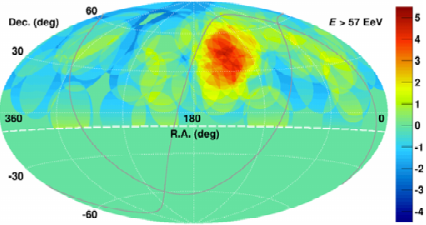
Figure 1. Hotspot in the arrival direction of UHECRs reported by TA. [1]